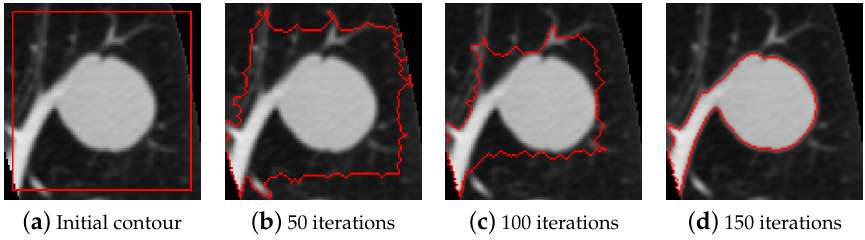
Figure 11. An example of activecontours